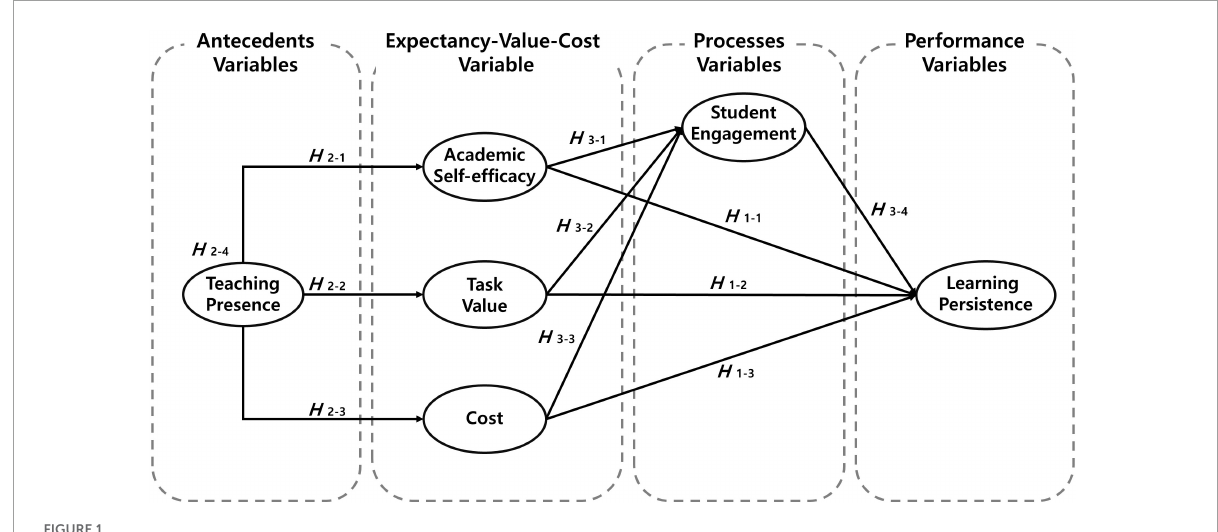
FIGURE1 The research